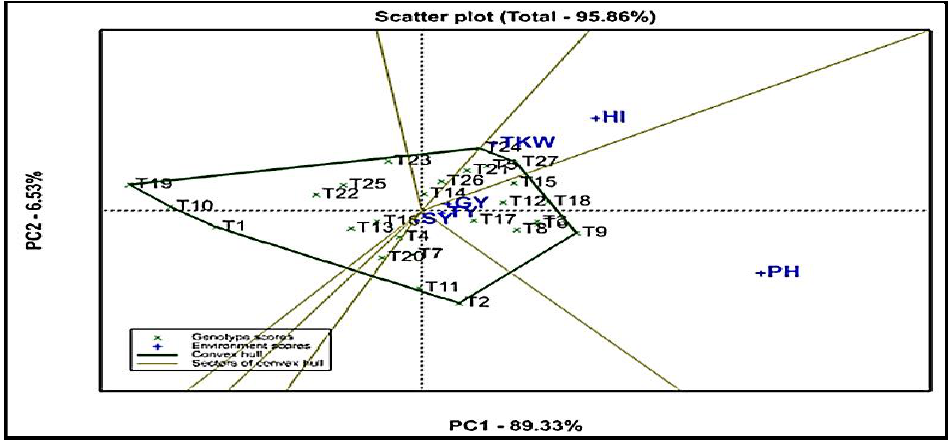
Figure 5. Polygon (which won where) view of the barley treatment-by-trait (TT) biplot of twenty- seven treatments for six traits. Abbreviations: biological yield (BY), grain yield (GY), straw yield (SY), 1000-kernels weight (TKW), plant height (PH), and harvest index (HI). T 1 to T 27 refer to Table